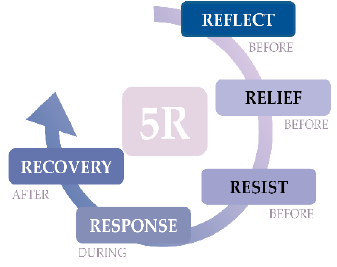
Figure 8. Flood resilience assessment created for macro scale Flood Resilience Index evaluation (reprinted from “Flood Resilience Index—Methodology and Application” by Batica and Gourbesville (2014), p. 7, Figure 3).